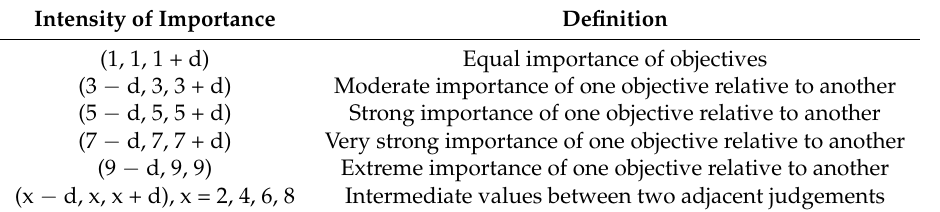
Table 1. Fuzzified Satty’s scale for triangular fuzzy numbers